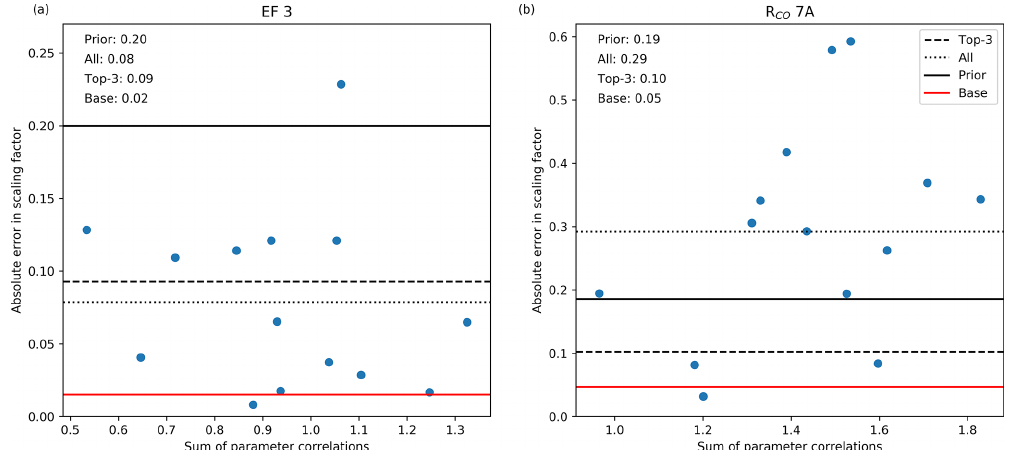
Figure 13. Scatter plot of the absolute error in the scaling factor of the industrial emission factor (EF 3) and R CO of road traffic (7A) against the sum of the parameter correlations of the same parameters. The correlation coefficients are − 0 . 17 and 0.37, respectively. The horizontal lines give the average absolute error in the scaling factor for the prior (full black line), if all 14d are averaged (dotted line), and based on the 3d with the smallest parameter correlations (dashed line) and the result for the base run (full red line). The values are also